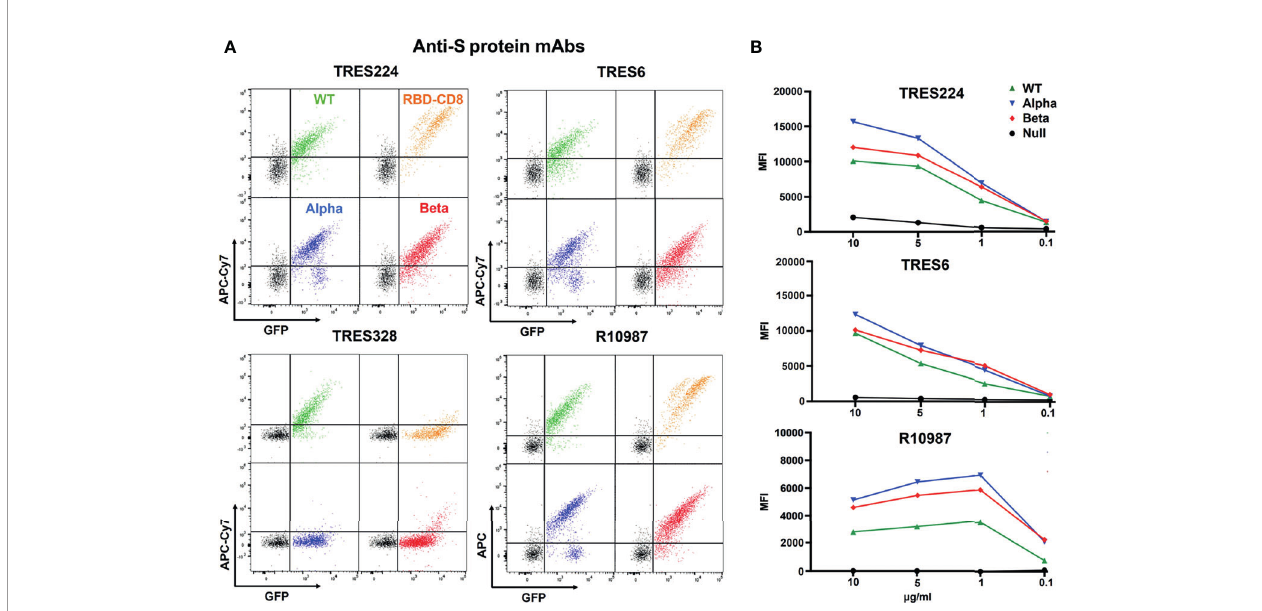
FIGURE 3 | BSFA study of the binding of four monoclonal antibodies (mAb) to S protein- expressing Ramos cells. (A) Ramos cells carrying the WT (green), alpha variant (blue), beta variant (red) S protein or the RBD-CD8 construct (orange) cells were incubated with 1 ug/ml of the mAb TRES224, TRES6, TRES328 and R10987. After washing, the cells were stained with either APC-Cy7-coupled anti-mouse IgG antibodies (for TRES224, TRES6, TRES328) or APC-coupled anti-human IgG antibodies (for R10987) and analyzed for the APC-Cy7/APC and GFP color by fl ow cytometry. (B) Titration of the mAb TRES224, TRES6 and R10987 to Ramos cells carrying the indicated S proteins. As negative control we used Ramos cells without S protein (black). The mean values of three different experiments are shown.